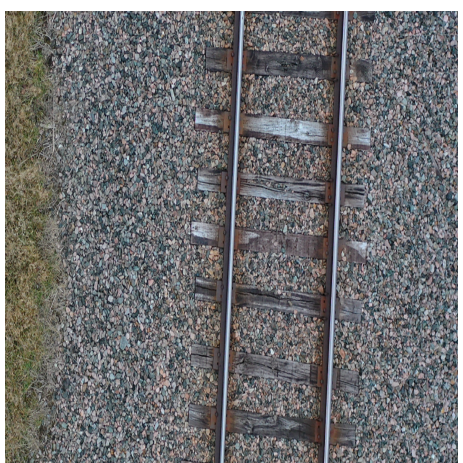
Figure 21. Negative broken tie detection.